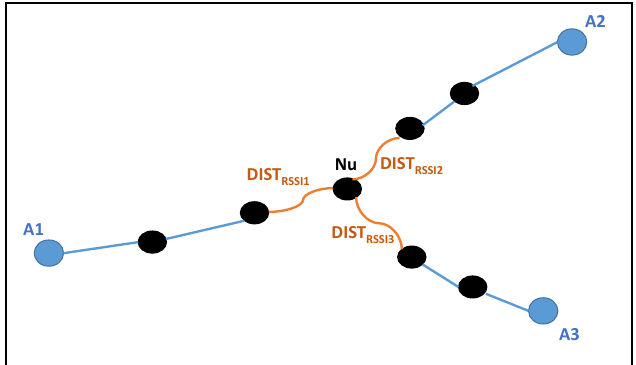
Figure 3. Example of a wireless sensor network. Localization of node N U using RSSI values and HopCount to